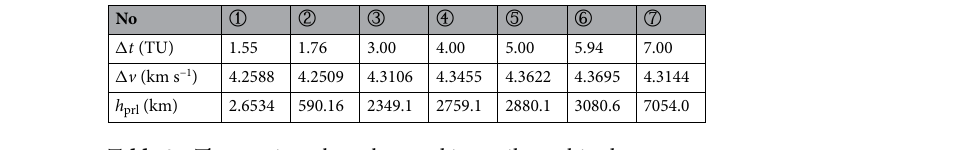
Table 3. The two-impulse values and its perilune